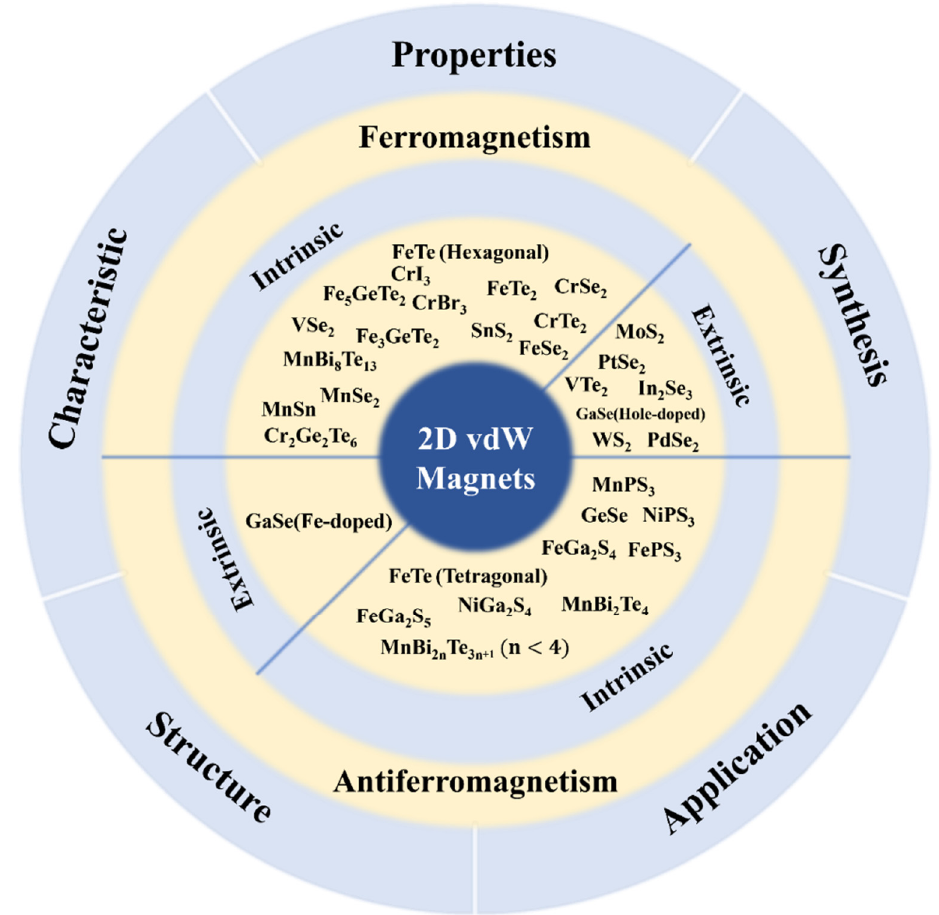
Figure 10. TOC : Based on the magnetic properties of 2D vdW materials, this review summarizes most known materials with intrinsic/extrinsic antiferromagnetism or ferromagnetism, including their structures, characteristics, properties, fabrication methods, and